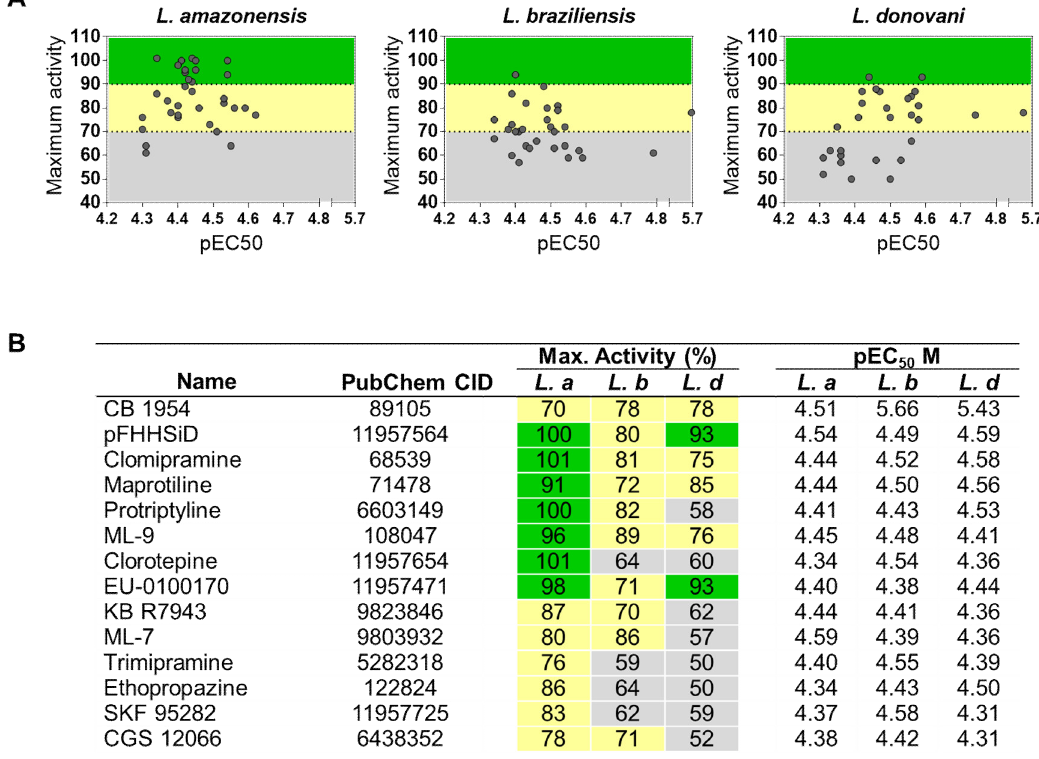
Figure 4. Confirmatory screening of a diversity-based library against Leishmania species panel. ( A ) Scatter plot distribution of compounds based on pEC 50 values and maximum activity (%). ( B ) Activity profile of pan-leishmanial compounds in terms of potency and efficacy. Colors indicate: max. activity > 90% (green), 70% < max. activity < 90% (yellow), and max. activity < 70% (grey). Max. activity is the mean value of normalized activity percentage at 50 µM of four independent experiments. pEC 50 = -log EC 50 (M). pEC50 is the mean value of two independent experiments. L.a = Leishmania amazonensis; L.b = Leishmania braziliensis , and L.d = Leishmania donovani.